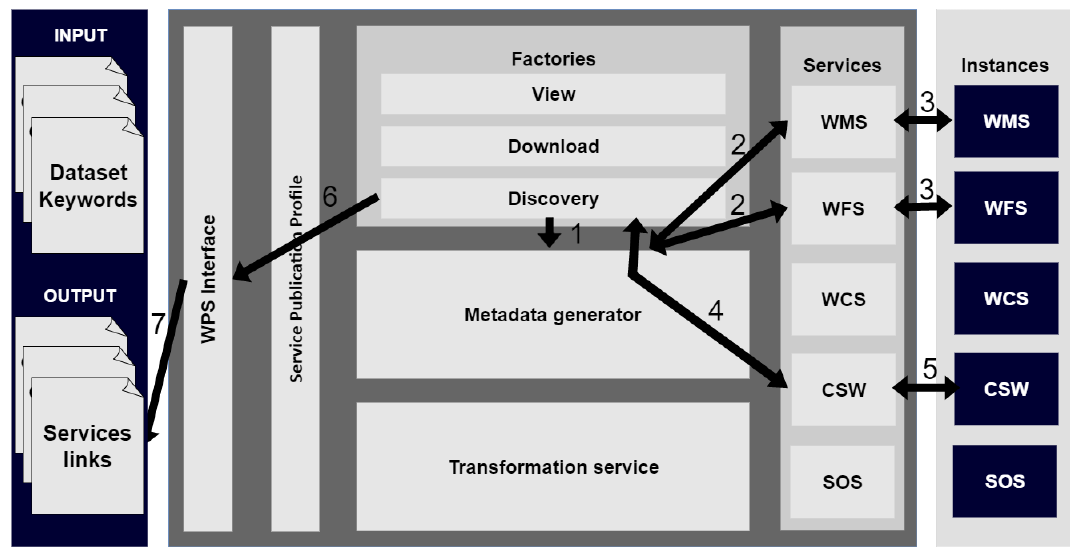
Figure 7. Different steps for the creation and publication of metadata using GSF.